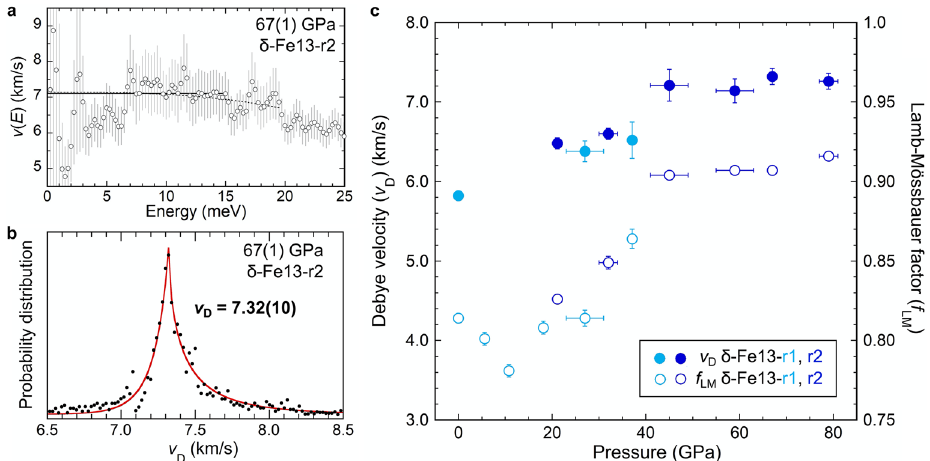
Figure 2. (a) An example of the Debye sound velocity determination of δ-Fe13 from the pDOS determined at 67 GPa. Examples of two typical phonon dispersion models that are traditionally used for constraining the Debye sound velocity ( v D; v ( E ) at E = 0) are plotted: the Debye-like model (horizontal black solid line) and the power law model (Eq. 1, black dotted line). The open circles are the pDOS data plotted according to Eq. (2). We note that the fit models plotted here are purely demonstrative and do not directly reflect our reported Debye velocities. Families of these models are considered, fit to the data, and plotted as probability distributions (ref. 33 ) of the v D . (b) The energy ranges applied in the PDF analysis at 67 GPa fall within, but are not limited to, the E min and E max values given in Table S1. See text for a detailed description of our Debye velocity determination method. (c) The correlation of v D (solid circle) and Lamb–Mössbauer factor ( f LM , open circle) of the δ-Fe13 samples; v D values account for the 57 Fe enrichment of the